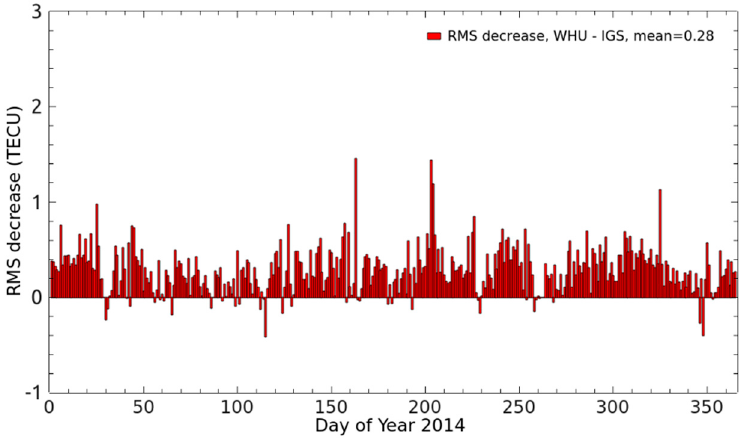
Figure 7. RMS decrease of differences in VTEC maps between Wuhan University (WHU) GIMs based on Bayesian estimation and the IGS final GIMs compared to those between GIMs based on original LSE and the IGS final GIMs.